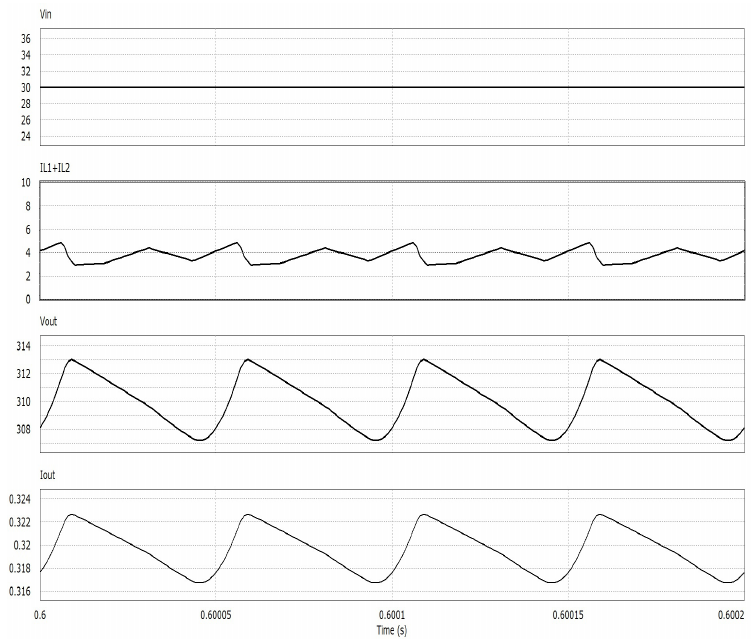
Figure 12. Simulation of input voltage, input current, output voltage and output current. Figures 13 and 14 show the hardware and simulation waveforms of the output voltage during startup. In the simulation waveform, the output voltage rises to a steady-state value within 400 ms. Practically, it can be seen that the output voltage rises to a steady-state value within 100 ms. This is within acceptable variation limits. It is also seen that the converter does not have any peak overshoot.